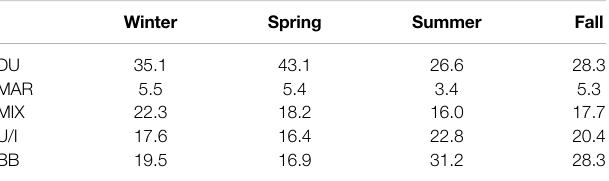
TABLE 4 | Seasonal aerosol-type distributions. Values represent the total percentage (i.e., Northern and Southern Hemispheres) for each aerosol category. Each column sums up to 100%.